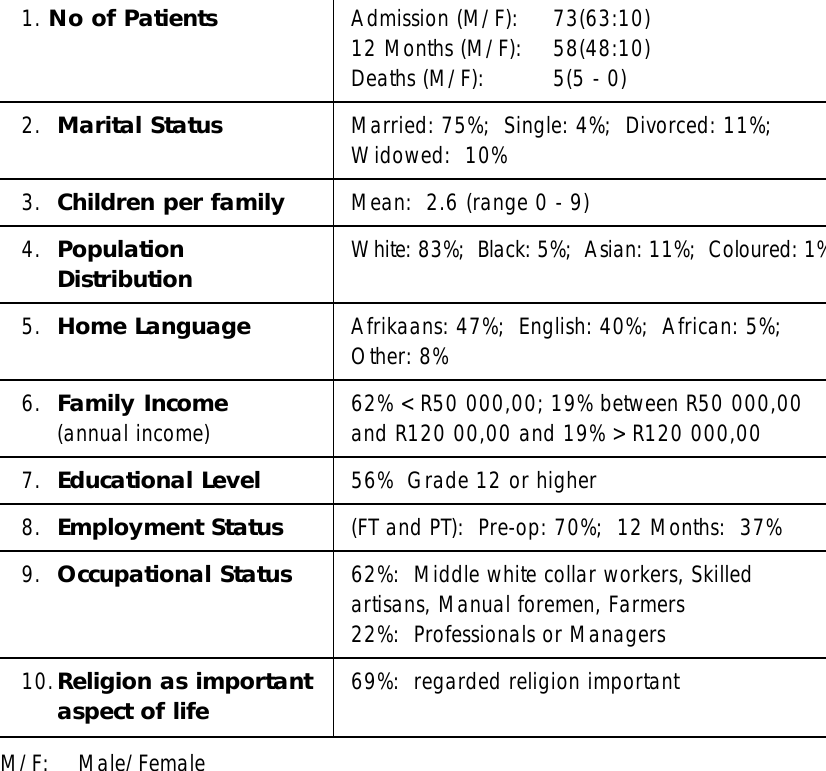
Table 1: Sociodemographic Information.